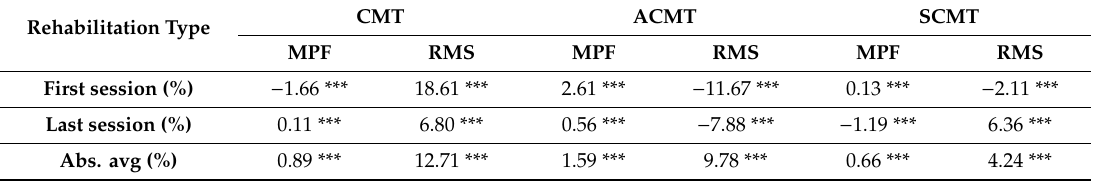
Table 3. Muscle fatigue analysis using median power frequency (MPF) and root mean square (RMS). Rehabilitation